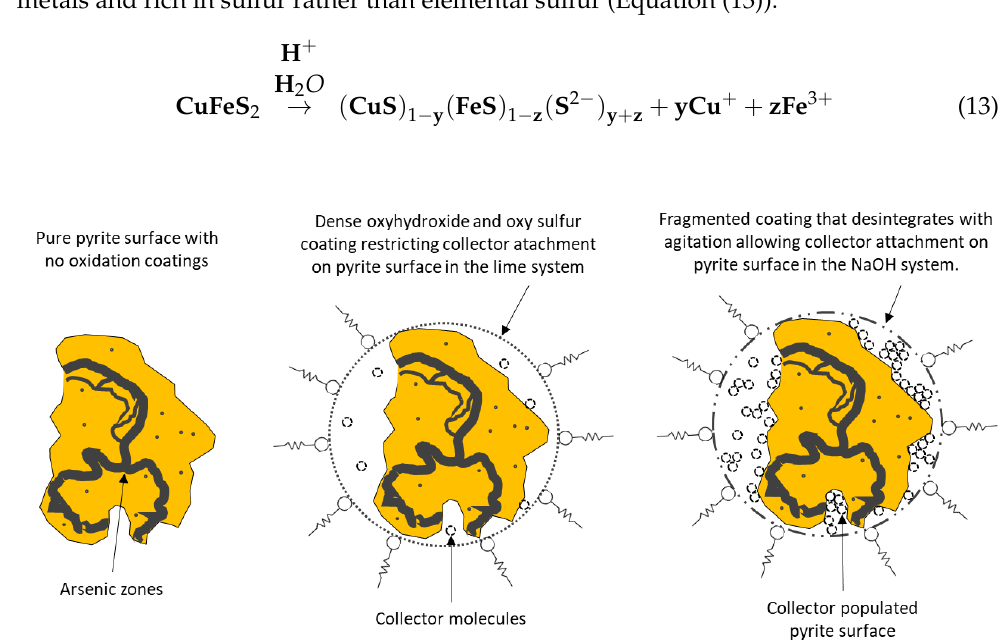
Figure 19. Mechanisms of interaction between the sulfide mineral surface and the collector. Both